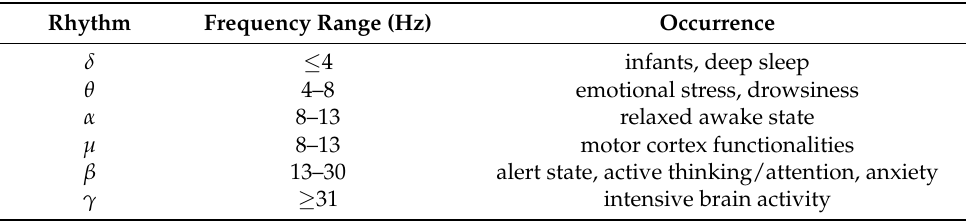
Table 3. EEG rhythms overview. The frequency ranges and the occurrence of the EEG rhythms are